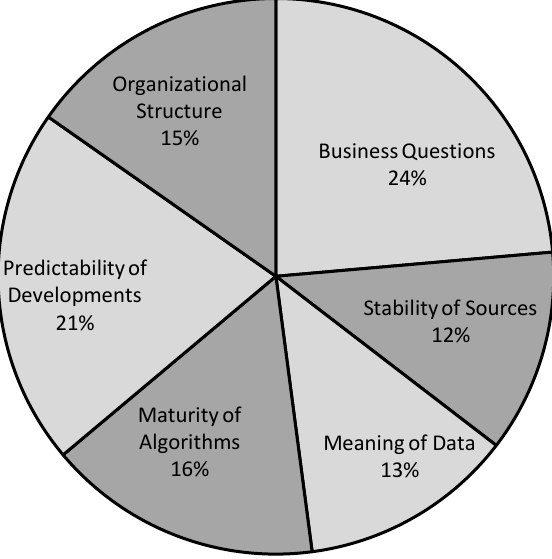
Figure 5. Impact of the identified dimensions on the dynamism